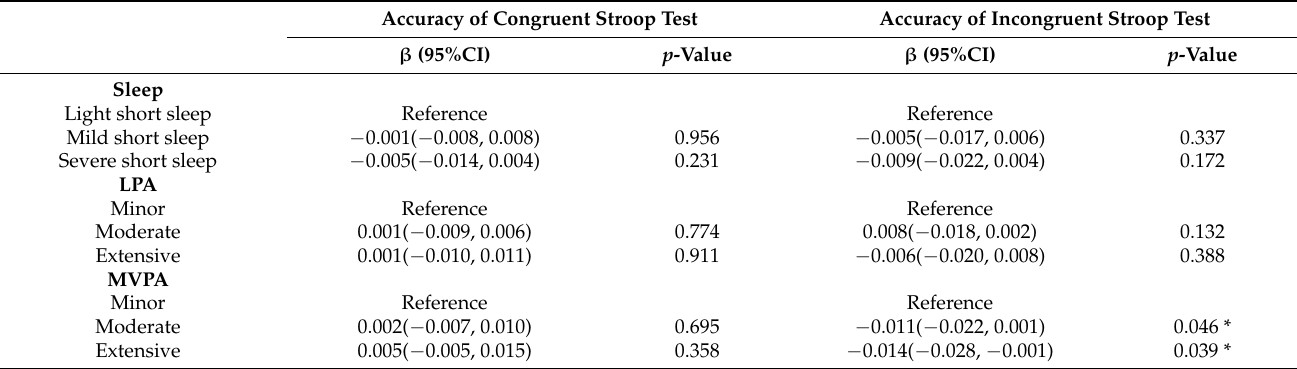
Table 3. The associations between sleep and physical activity with congruent and incongruent Stroop test